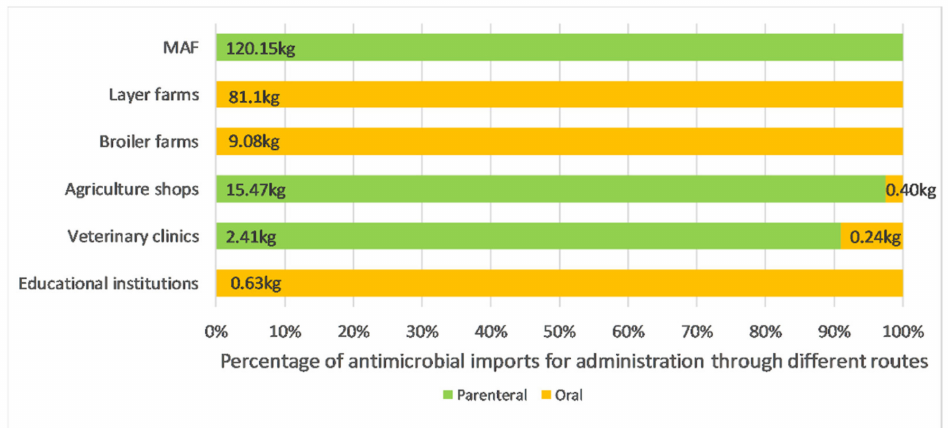
Figure 6. Profile of antimicrobial imports of different importer types, by recommended route of administration. Antimicrobials for administration via the topical route represented less than 0.3 kg (0.1%) of total imports and were therefore not included in the